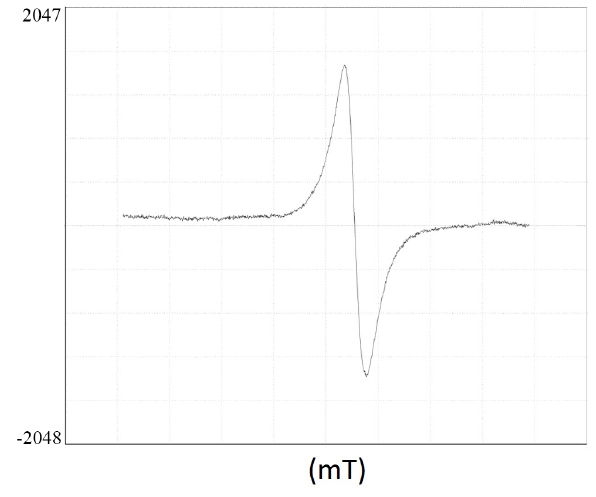
Figure 5. Typical ESR spectrum of humic substances investigated.